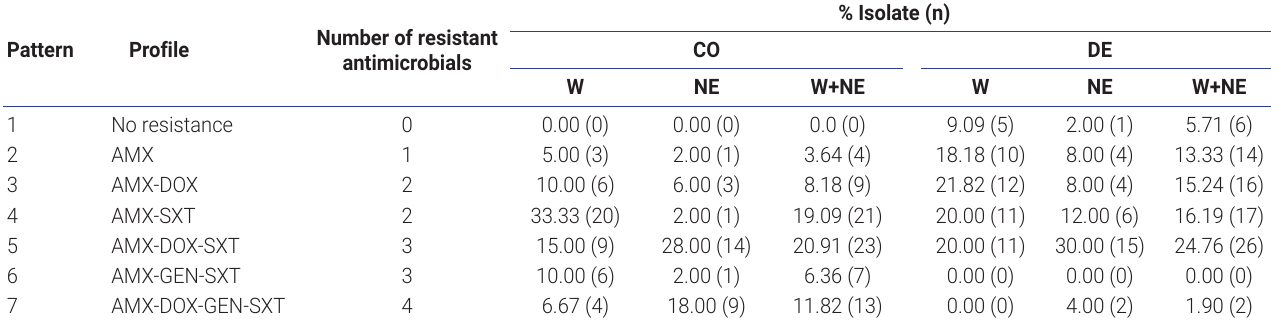
Table 4. Ten most common antibiograms of Escherichia coli isolates of the conventional system (CO) and the deep litter system (DE) in the cur- rent study